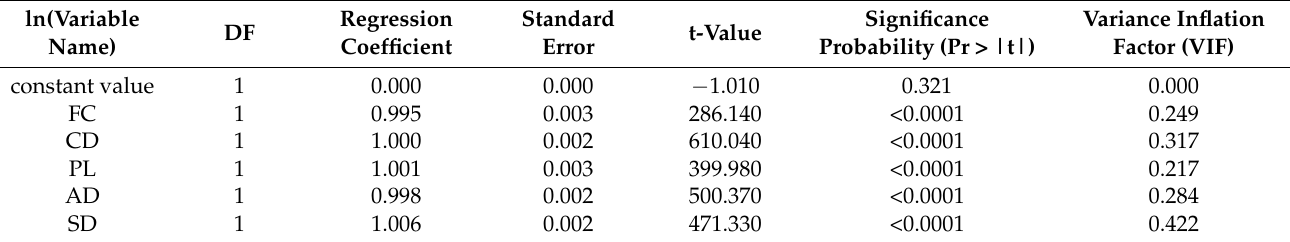
Table 12. Results of the multiple regression